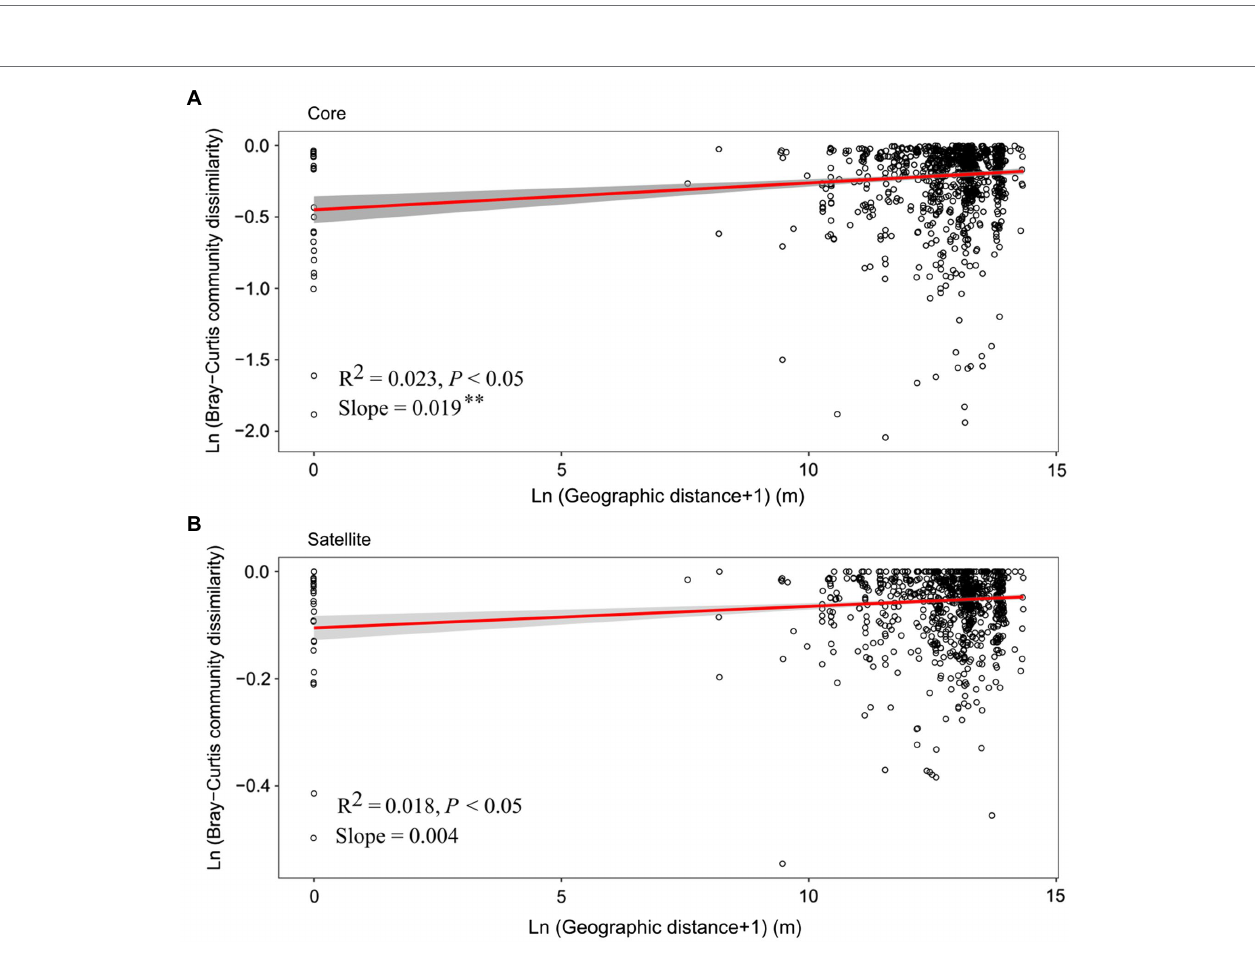
FIGURE 3 | Comparison of α -diversities of the core and satellite bacterial sub-communities. (A) Chao1 index and (B) Shannon index.